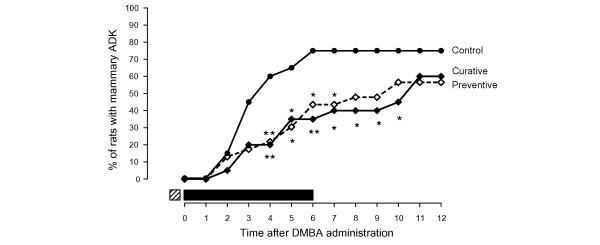
Incidence of mammary adenocarcinomas (ADKs) after daily administration of melatonin (10 mg/kg) for either 15 days before (preventive treatment; open diamonds) or 6 months after (curative treatment; filled diamonds) the administration of dimethylbenz [a]anthracene (DMBA). In both cases, the rats were followed up for 12 months after the administration of DMBA. Hatched bar, duration of preventive treatment; filled bar, duration of curative treatment. *P < 0.05 vs controls; **P < 0.01 vs controls.